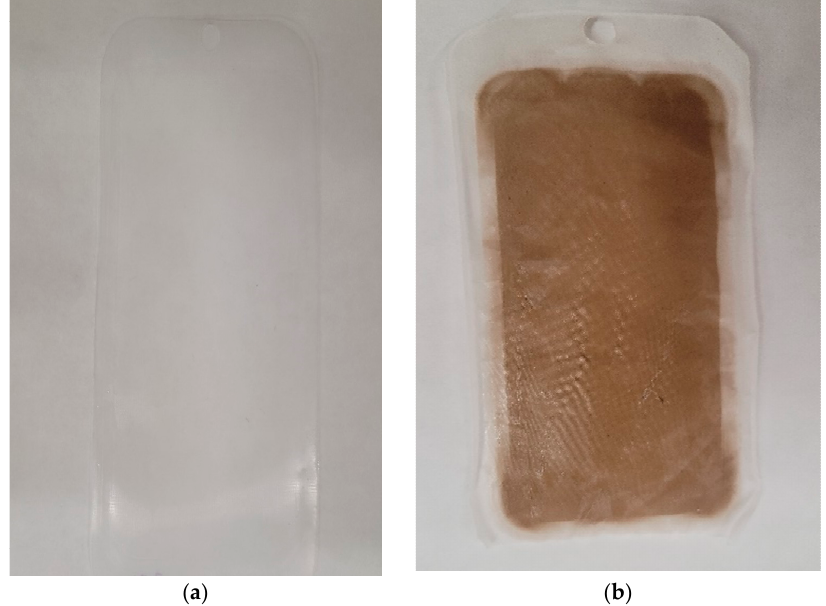
Membranes 2023 , 13 , x FOR PEER REVIEW Figure 4. CTA FO membrane: ( a ) uncoated membrane; ( b ) coated membrane. Figure 4. CTA FO membrane: ( a ) uncoated membrane; ( b ) coated membrane.